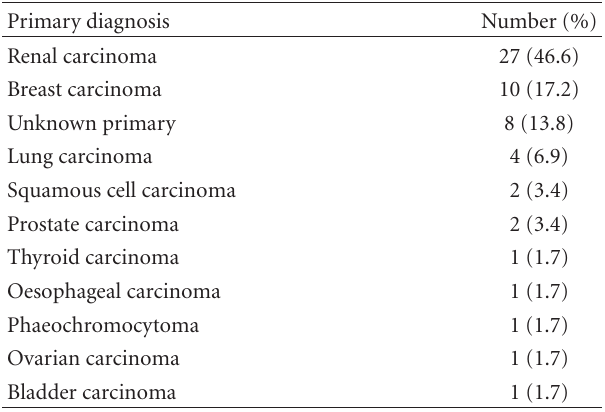
Table 2: Primary diagnosis of patients undergoing endoprosthetic